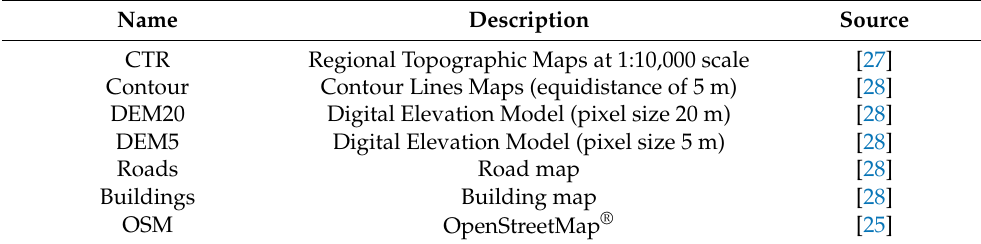
Table 2. Additional